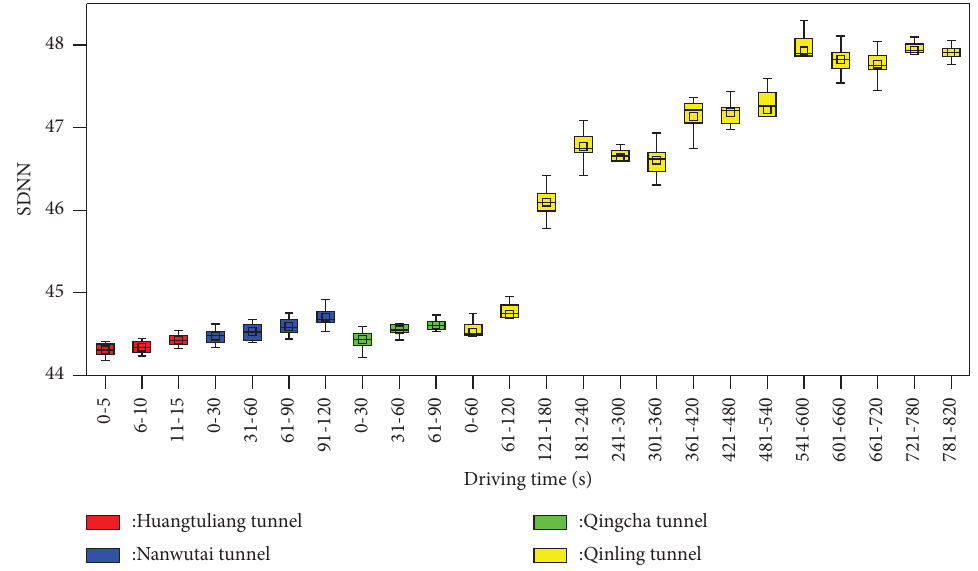
Figure 11: Changes in drivers’ SDNN in each tunnel.